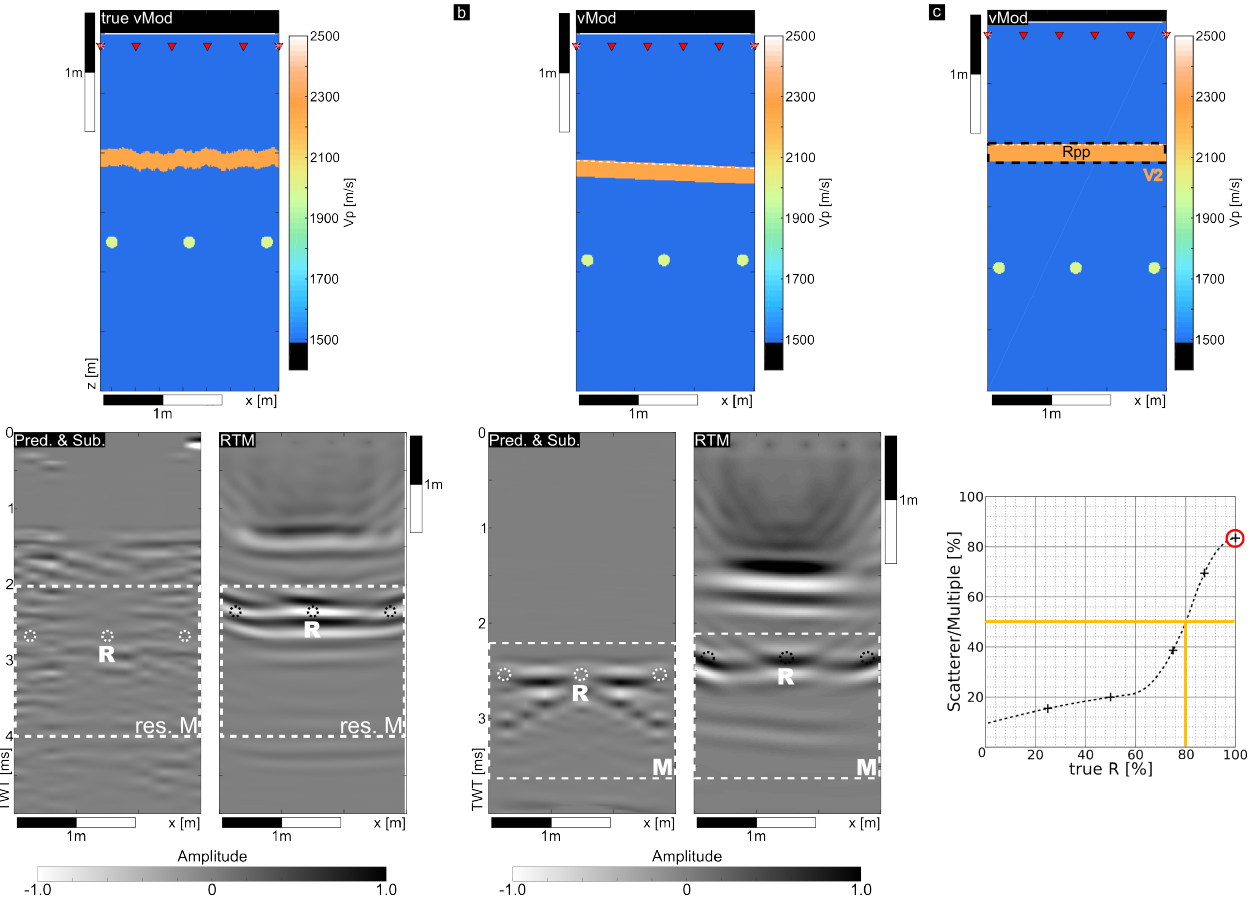
Figure 6. Velocity models and results for methods A and B for small scale variations in the water depth ( a ), a dipping water bottom ( b ) and incorrect estimation of the reflection coefficient ( c ). The amount of multiple energy removed for the estimated percentage of true reflectivity is shown in bottom panel ( c